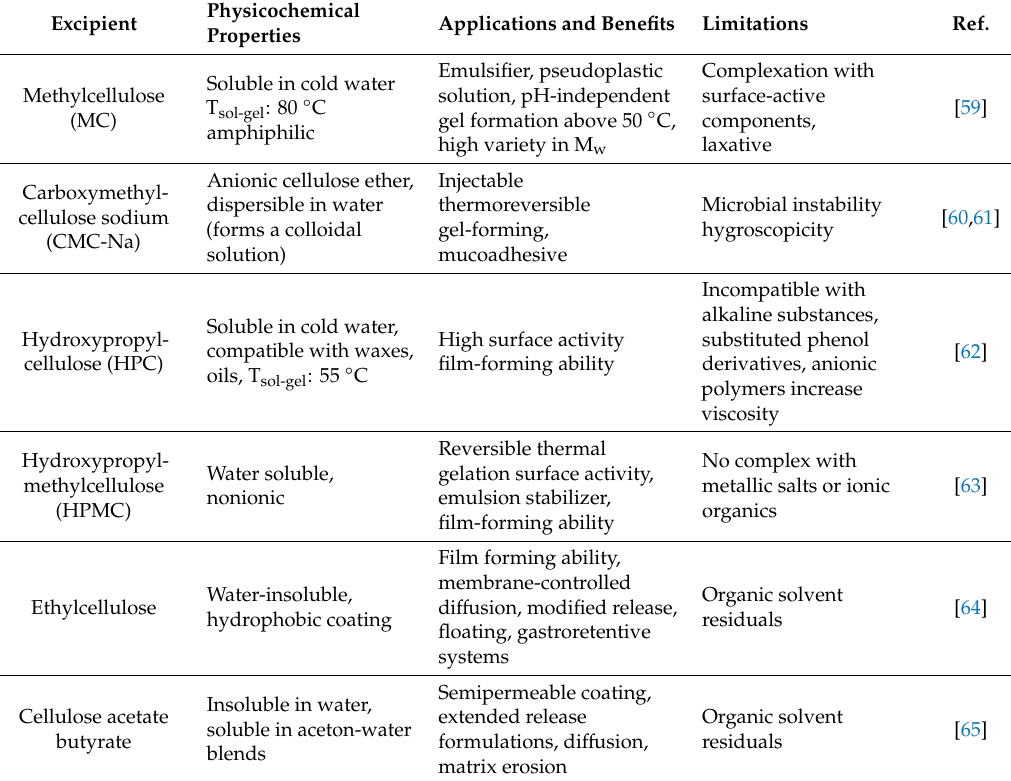
Table 4. Examples of cellulose derivatives applied in microencapsulation.